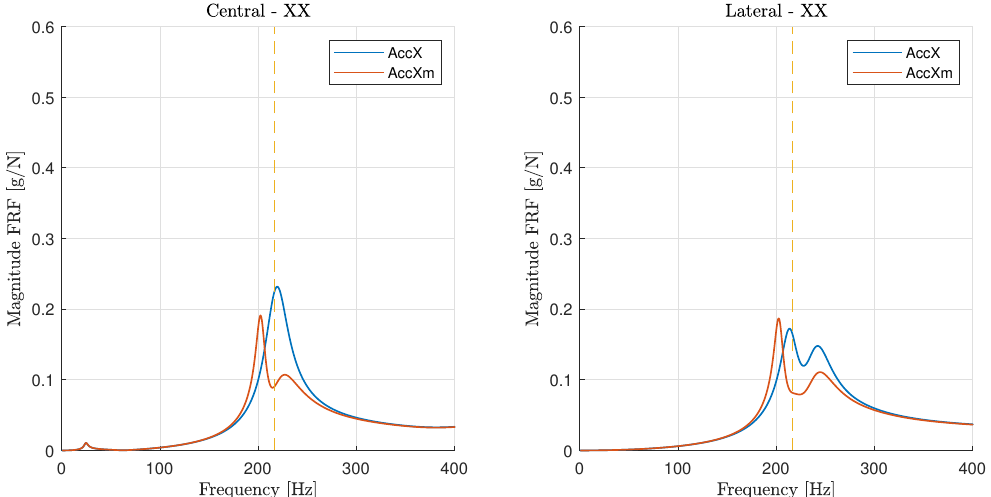
Figure 20. Comparison between the FRF of the model (blue) and the predicted FRF (orange), considering a vibration absorber tuned at f N = 212 Hz, in two different positions of the cutting head. Dashed line shows the working